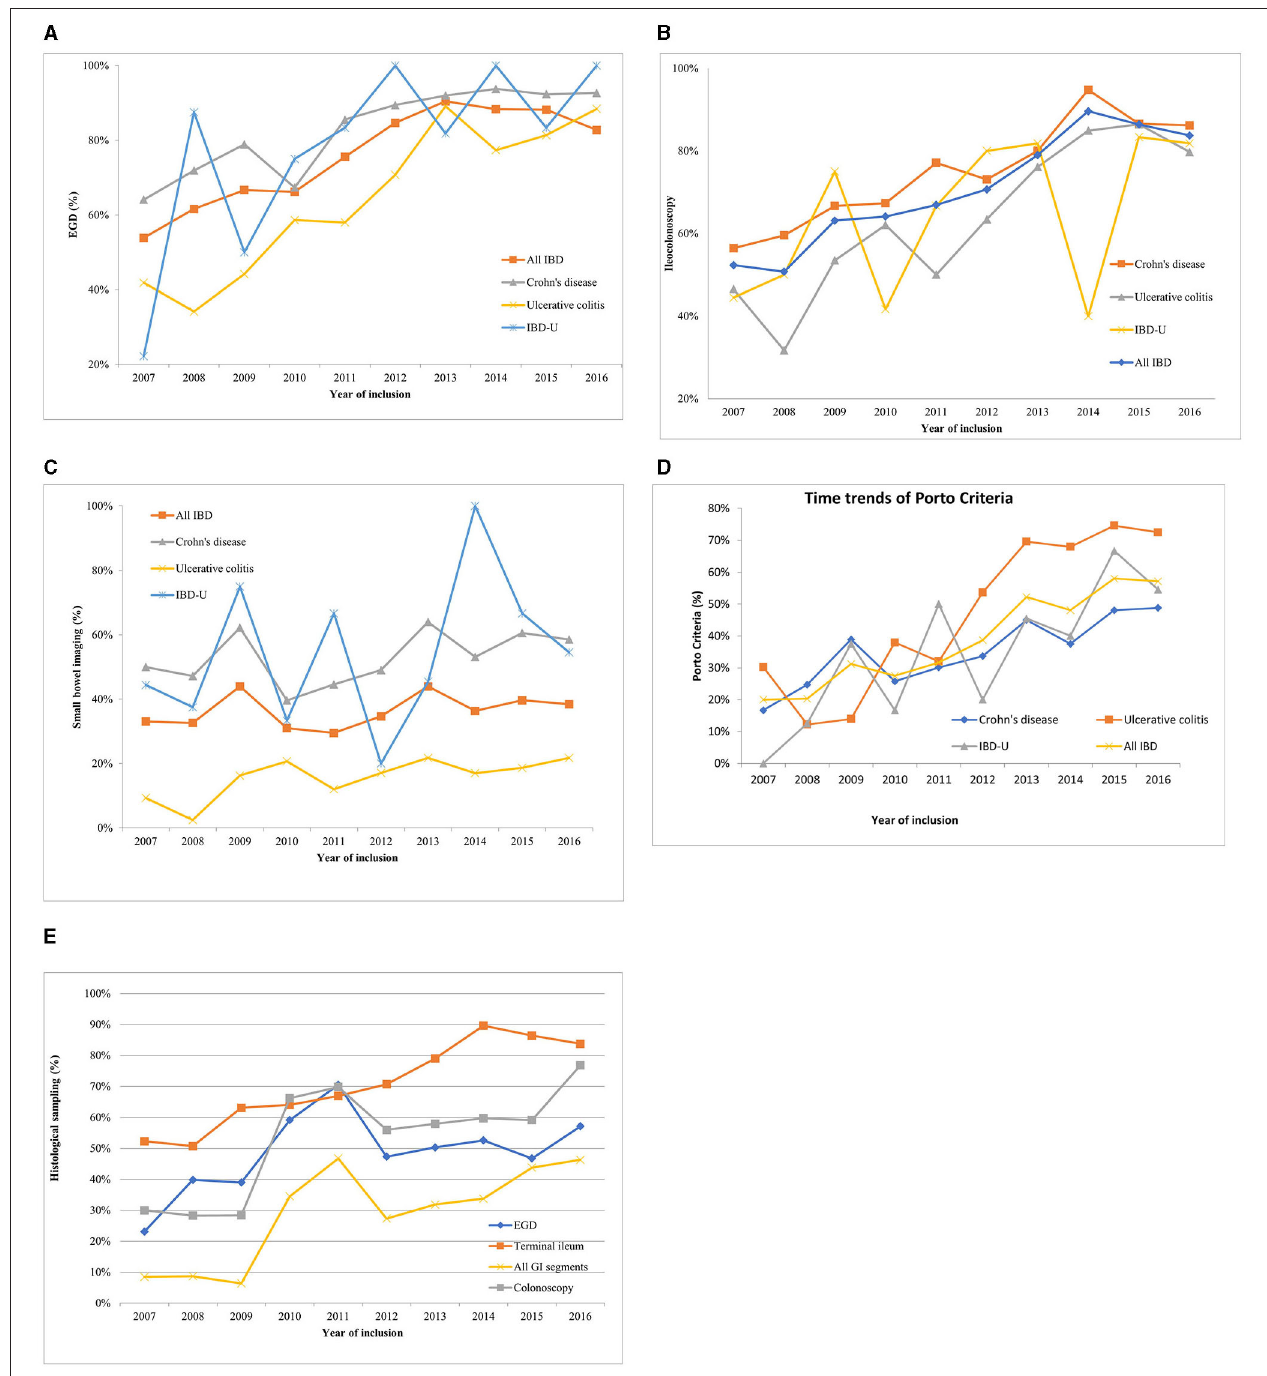
FIGURE 1 | Time trends of diagnostic procedures within the HUPIR cohort from 2007 to 2016. (A) Time trends of esophagogastroduodenoscopy in ulcerative colitis, Crohn’s disease and IBD-U between 2007 and 2016. (B) Time trends of ileocolonoscopy in ulcerative colitis, Crohn’s disease and IBD-U between 2007 and 2016. (C) Time trends of adequate small bowel imaging in ulcerative colitis, Crohn’s disease and IBD-U between 2007 and 2016. (D) Time trends of completed Porto criteria in ulcerative colitis, Crohn’s disease and IBD-U between 2007 and 2016. (E) Time trends of histology sampling in paediatric inflammatory bowel disease between 2007 and 2016. (748/1,191), TI: 91% (991/1,095), colonoscopy: 61% (832/1,363)], is still not an everyday practice to take biopsies from all segments and the difference was significant (EGD vs. TI, p < 0.0001, and TI ( Figure 1E ). The low rate of multiple biopsy samples is due to vs. colonoscopy p = the low sampling practice of EGD and colonoscopy [EGD: 63%